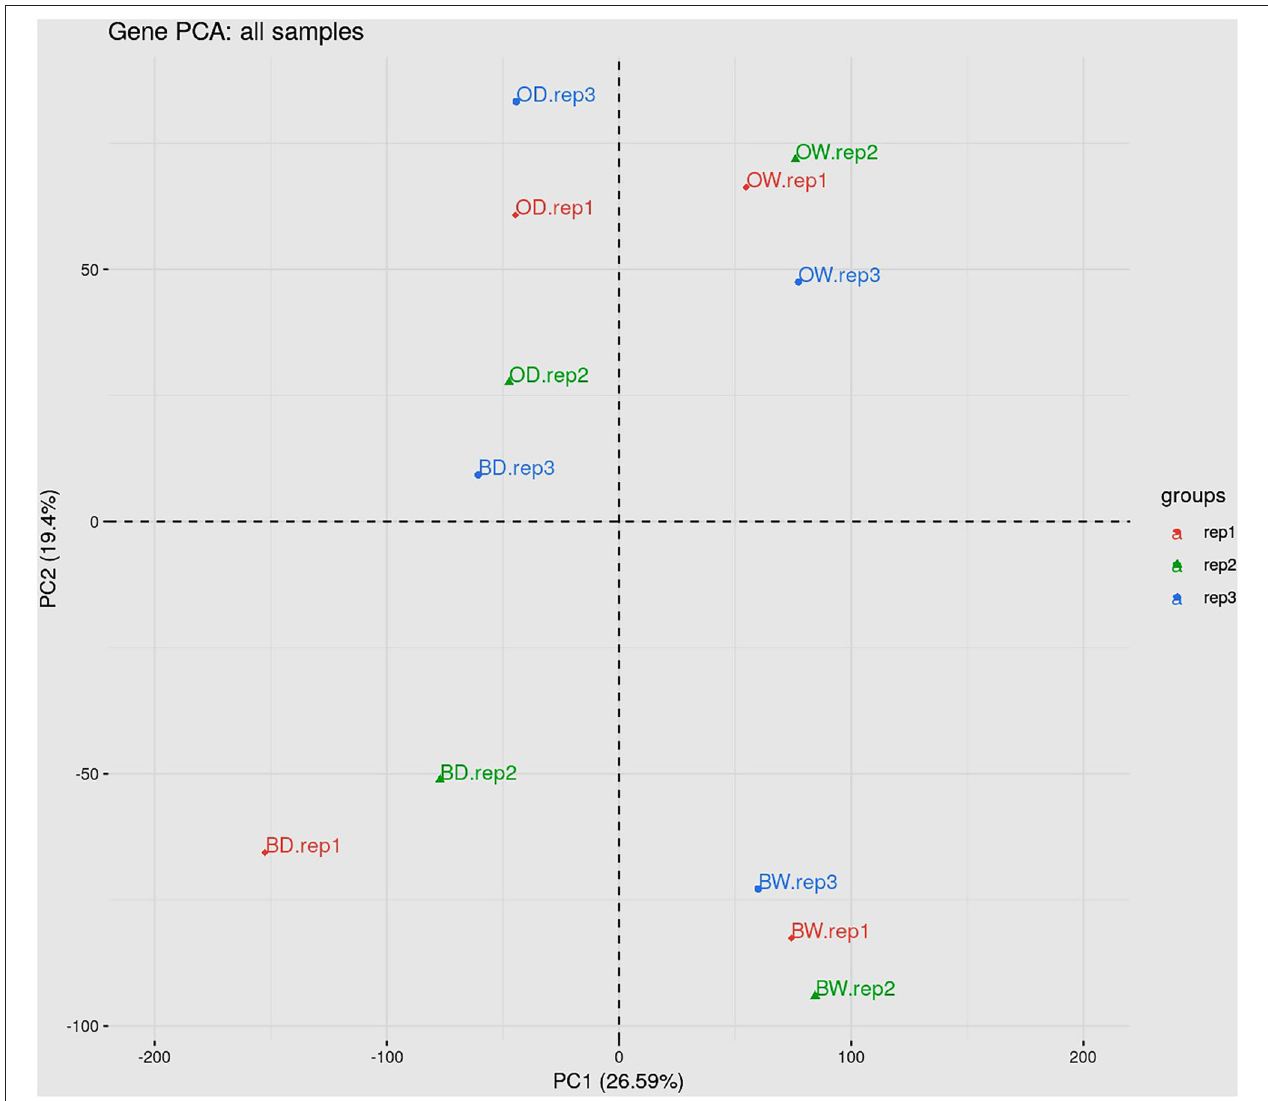
FIGURE 4 | Principal component analysis of the data showing the variation due to genotype and treatment.